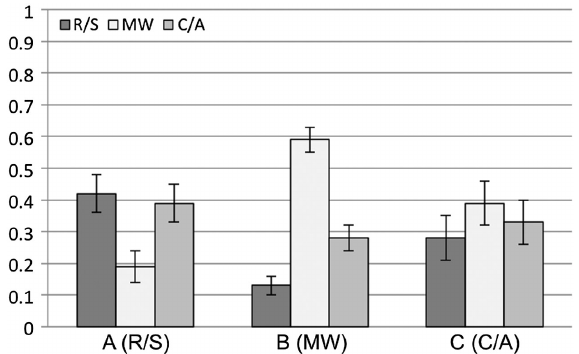
FIG. 5. Postinstruction student responses for courses A , B , and C . Students indicated whether they agreed, disagreed, or felt neutral about the statement: The probabilistic nature of quantum mechanics is mostly due to the limitations of our measurement instruments. N ¼ 69 ( A ), 135 ( B ), and 47 ( C ); error bars represent the standard error on the